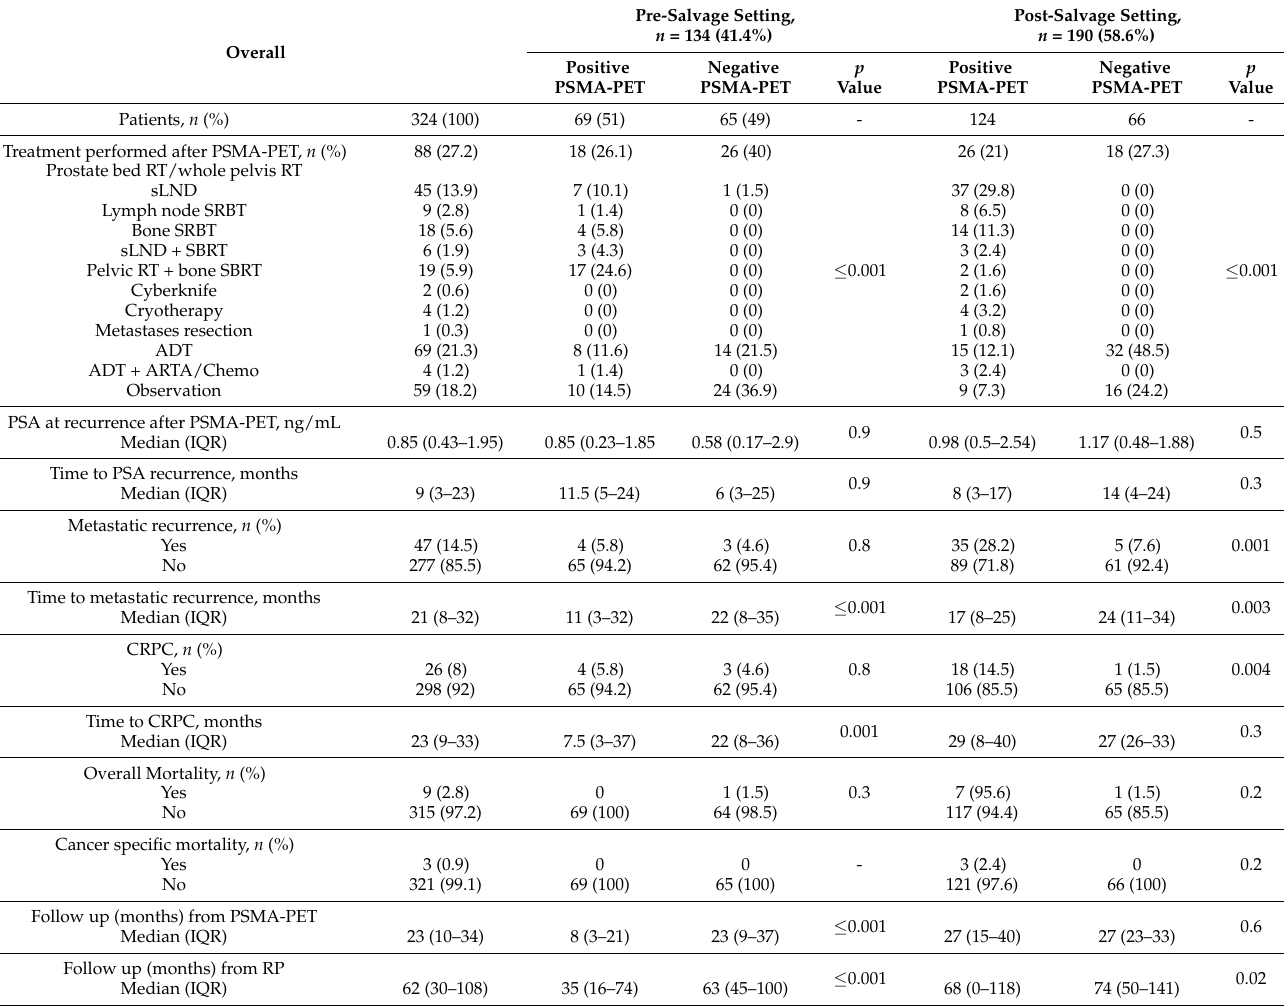
Table 2 showed the treatments performed after PSMA-PET and the oncologic outcomes after PSMA-PET. The median follow-up after PSMA-PET was 23 months (IQR:10–34; Table 2). Table 2. Oncologic outcomes after PSMA-PET results in the overall population ( n = 324), in the pre-salvage ( n = 134) and post-salvage ( n = 190) setting stratifying according to PSMA-PET results (namely, positive vs. negative). Pre-Salvage Setting, Post-Salvage Setting, n = 134 (41.4%) n = 190